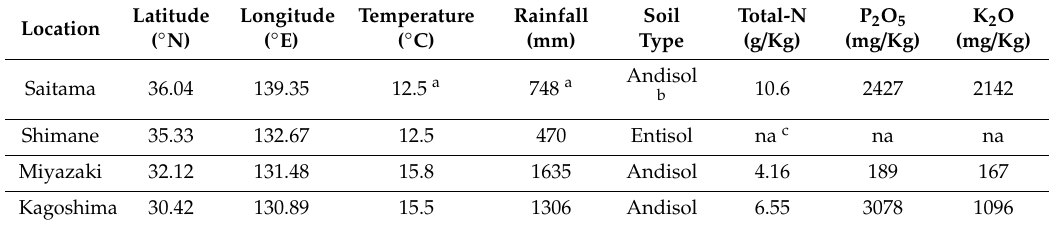
Table 1. Climate conditions and soil properties at the sweet potato-nursery